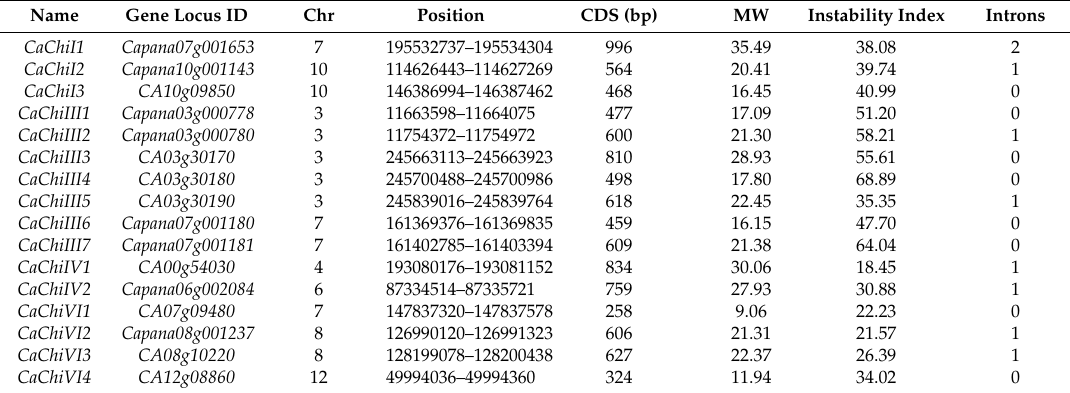
Table 1. List of Chitin-binding protein family genes identified in pepper and their sequence characteristics. Chr: chromosome; CDS: codding sequence; MW: molecular weight (kDa). the proteomic information was obtained from ExPASy (Available online: